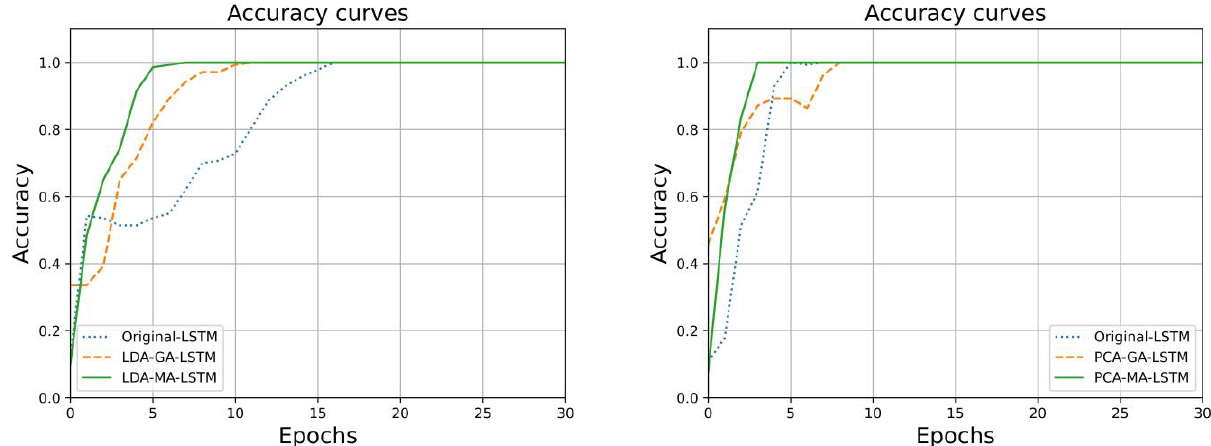
Figure 6. Accuracy curves of different LSTM models.